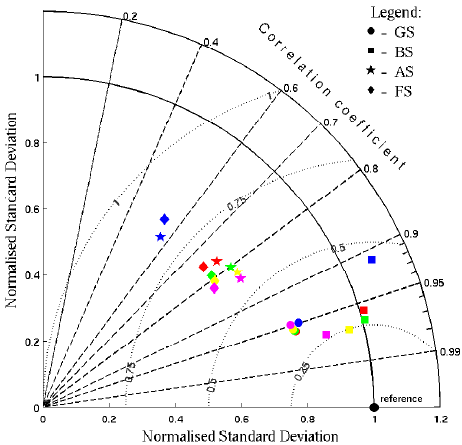
Fig. 4. Taylor diagram comparing oxygen fields calculated using different meteorological forcing at the principal stations for the pe- riod 1998–2003. Symbols representing the different stations are labelled in the figure. Different symbol colours categorise the vari- ation of wind speed scaling: 0.5 – blue; 0.8 – red; 1.0 – green; 1.2 – yellow; 1.5 – magenta.